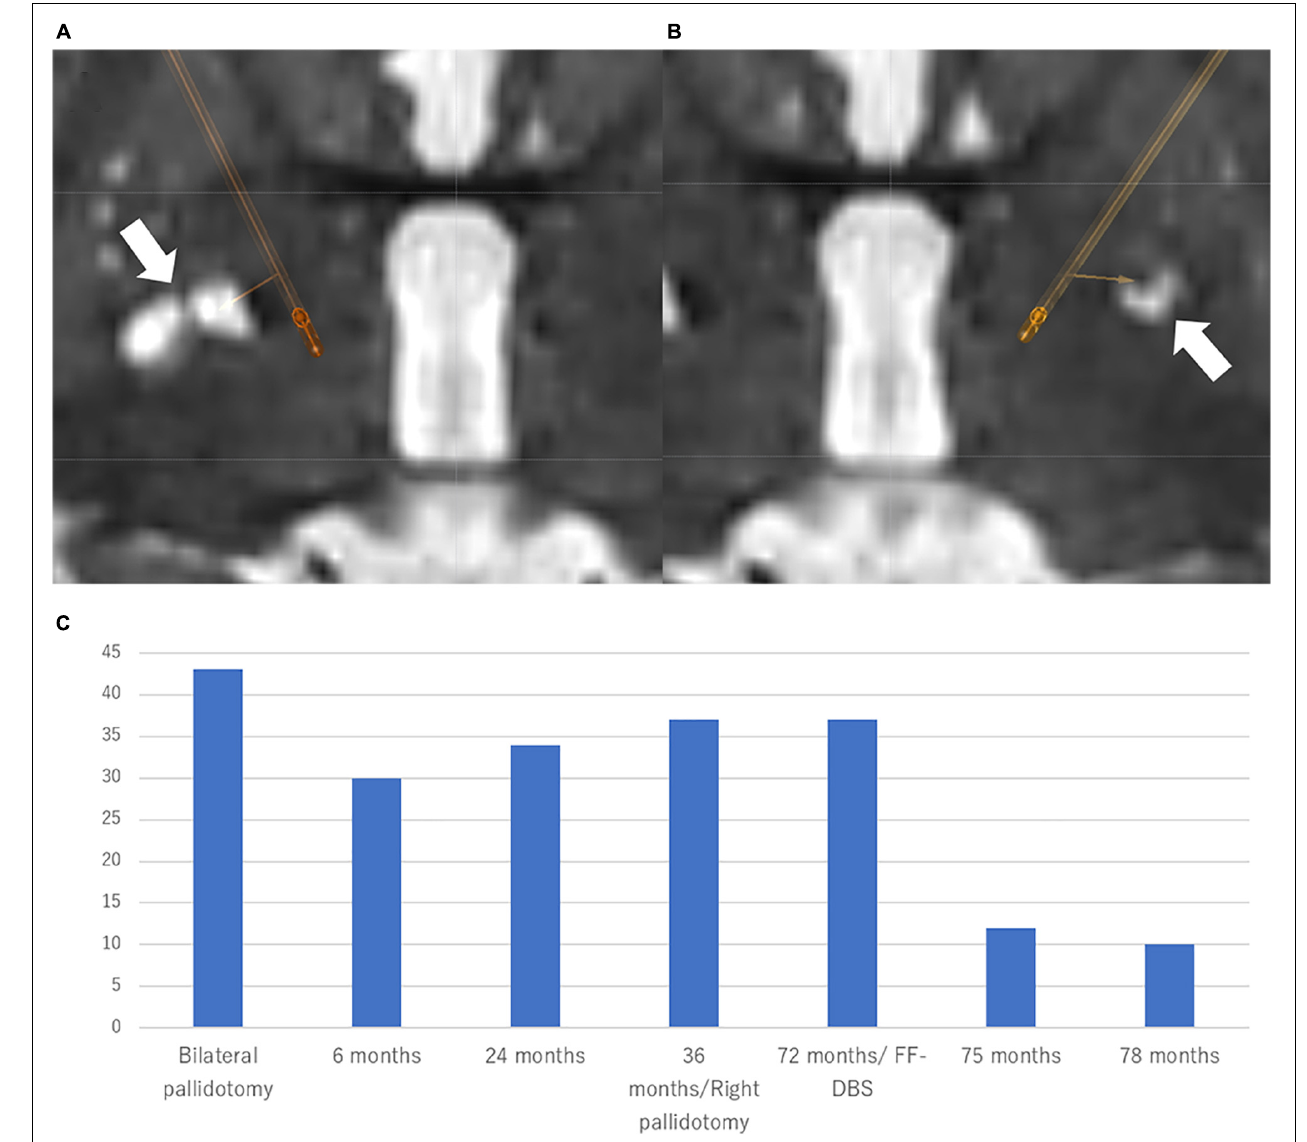
FIGURE 1 | Location of the electrodes and clinical course in Case 1 Patient. The electrodes were simulated by Brainlab elements using postoperative CT scan fused with preoperative T2-weighted MRI. (A) Right-side stimulation: 10-(8%)/11-(6%)/12-(6%)/13-(28%)/14-(26%)/15-(26%)/C +, 80 µ s, 159 Hz, 1.5 mA. (B) Left-side stimulation: 5-(34%)/6-(33%)/7-(33%)/C +, 80 µ s, 159 Hz, 2.5 mA directional DBS electrodes (Boston Scientific, Marlborough, MA, United States) were used. (C) The patient experienced a 91.7% improvement of BFMDRS at 6 months after the bilateral Forel’s field DBS. BFMDRS: Burke-Fahn-Marsden dystonia rating scale (range: 0–120) DBS, deep brain